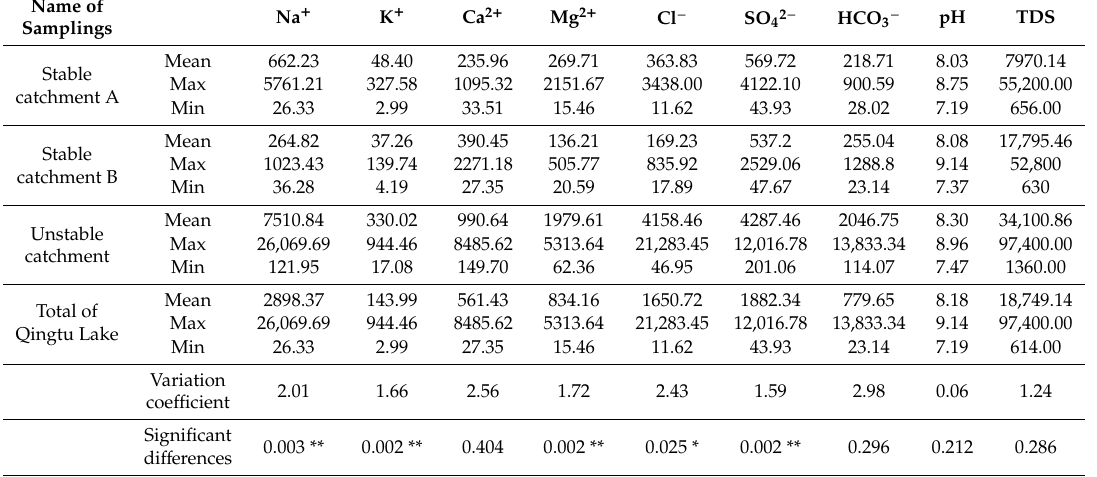
Table 2. Descriptive statistics of hydrochemistry of all available water samples (Units: mg L − 1 , except pH).